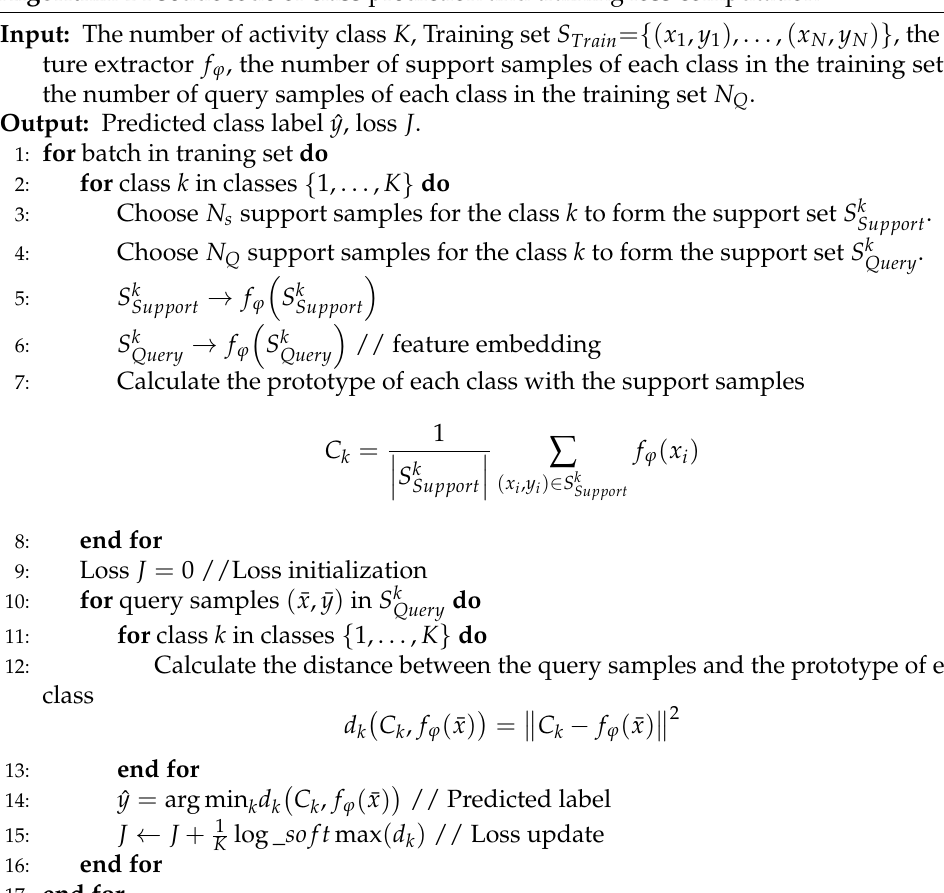
Algorithm 1 Pseudocode of class prediction and training loss